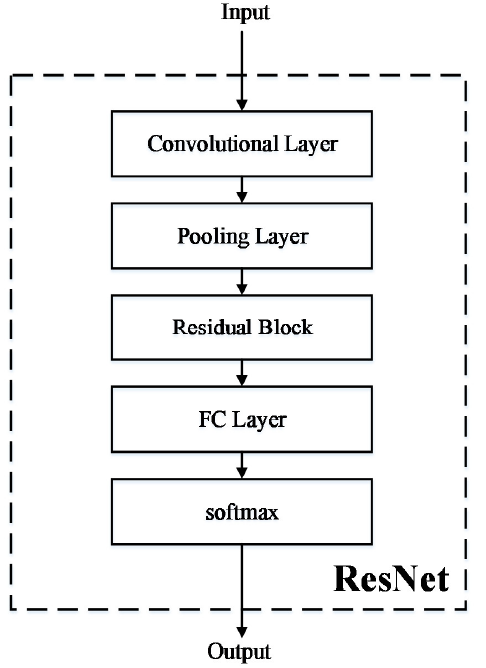
Figure 4. ResNet framework.